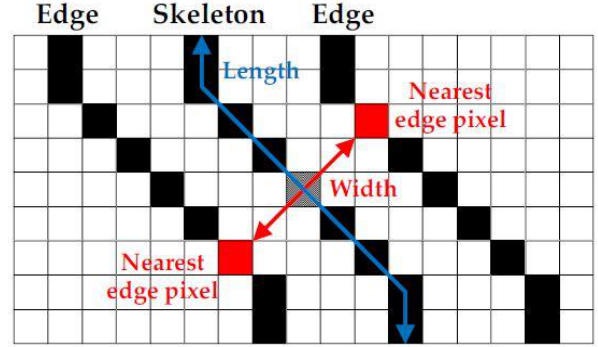
Figure 9. Visual representation of predicting the crack width.